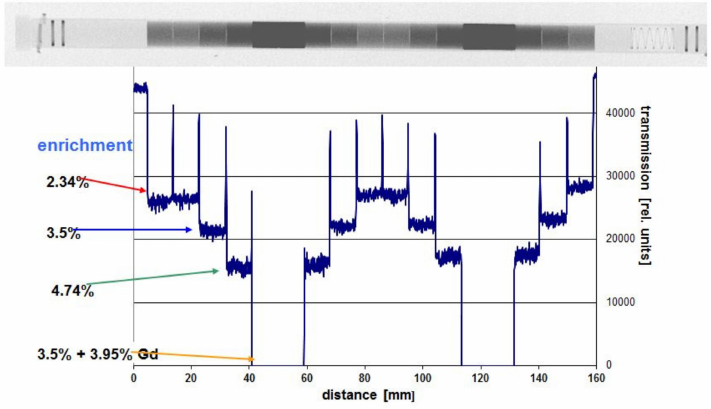
Figure 5. Transmission contrast and enrichment along a fuel pin also containing two sections with Gadolinium as a “burnable poison”. The outer diameter of the cylindrical samples is approximately 10 mm, copyright permission by Elsevier, 2003 [3].